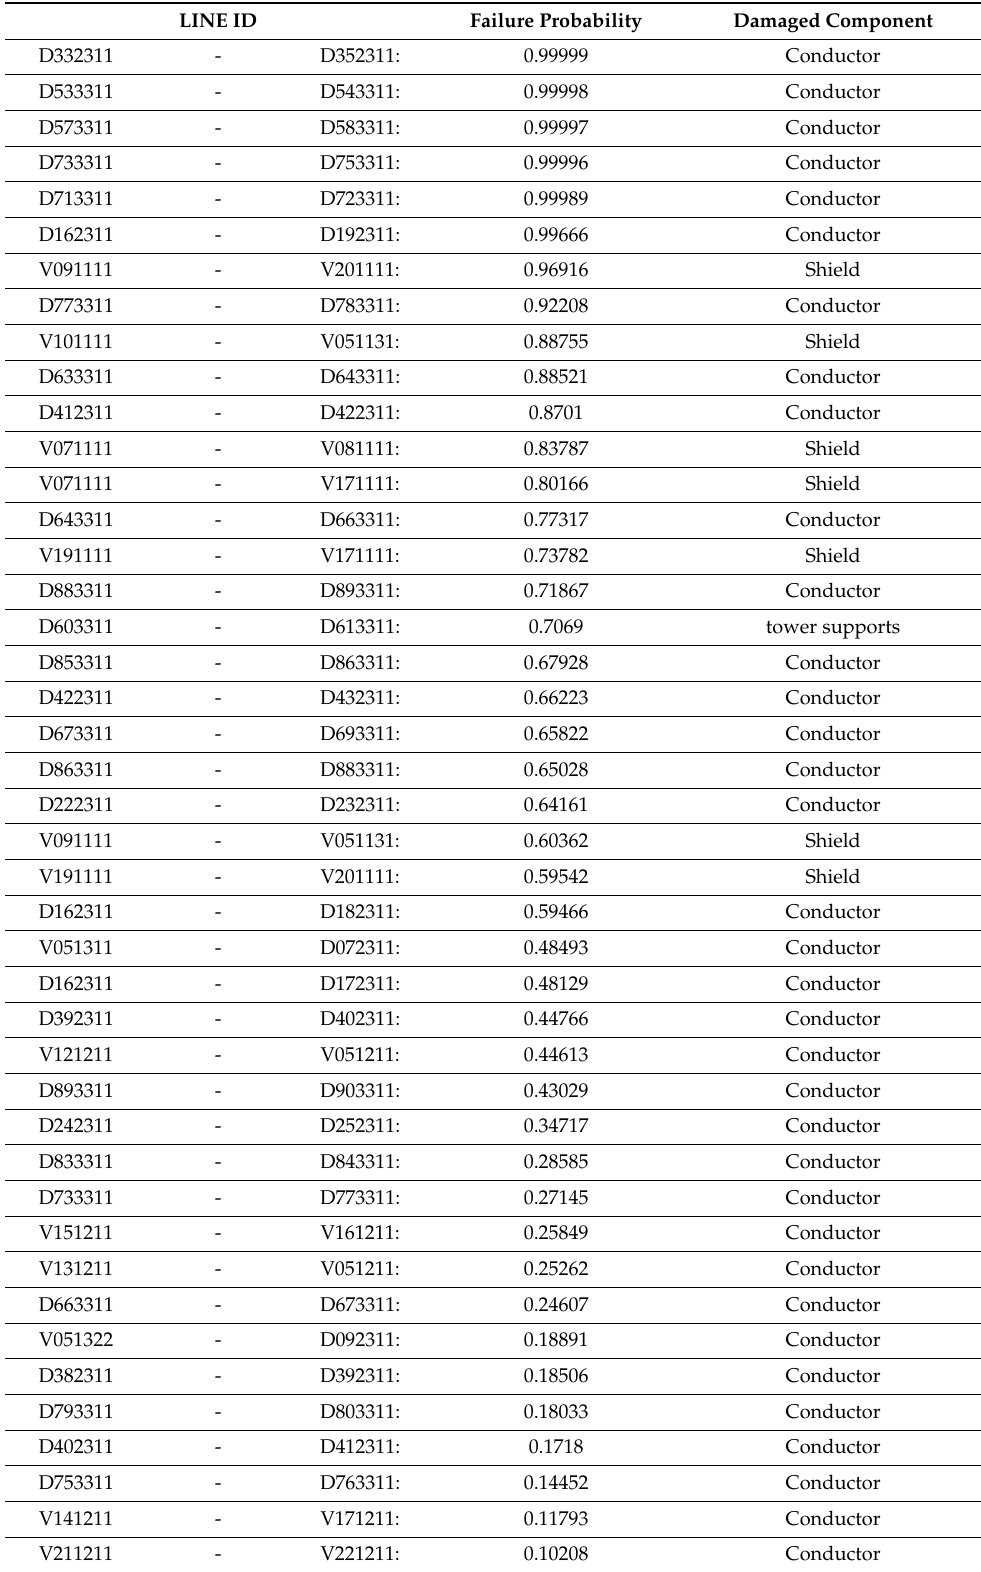
Table 6. List of critical components with their failure probabilities over 10 min, case